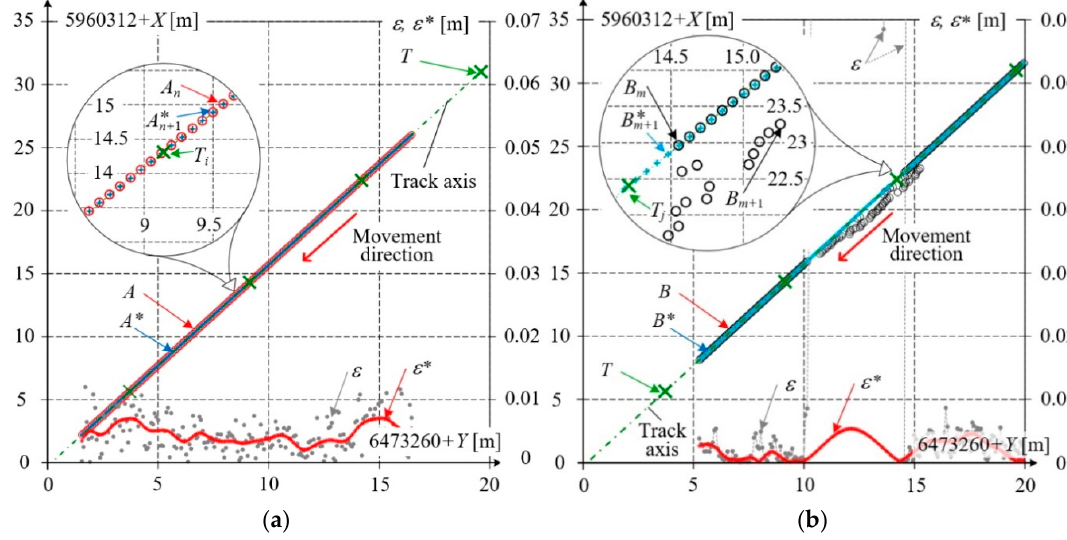
Figure 16. Measurement results obtained from receivers A , B and total station T , and distribution of absolute errors: ε for A , B and ε * for A *, B *: ( a ) receiver A ; ( b ) receiver B .